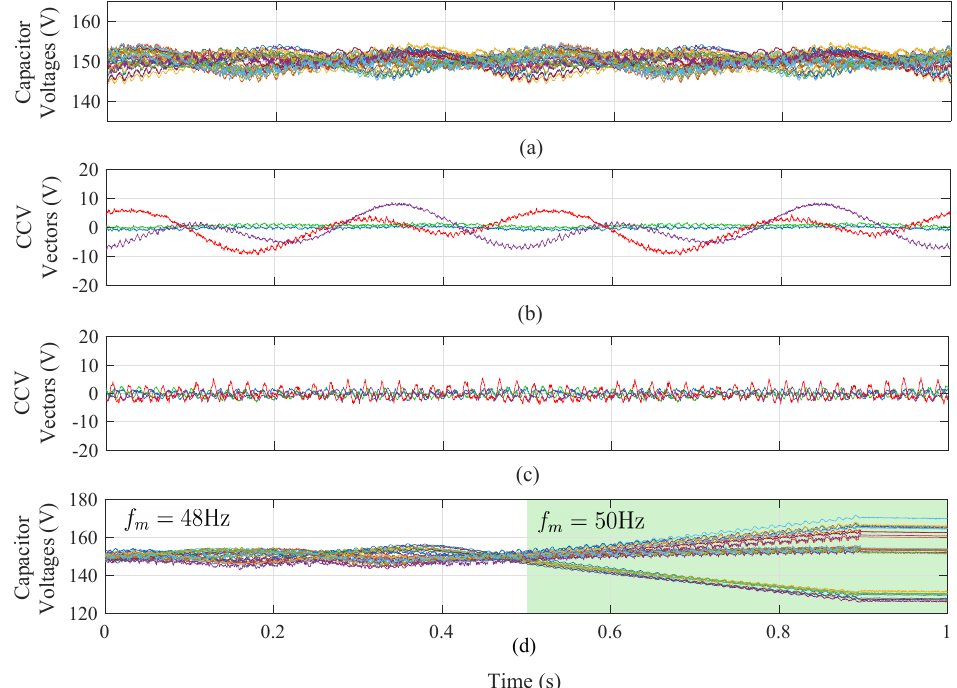
Figure 15. Experimental results considering open loop operation. ( a ) Twenty-seven floating capacitor voltages. ( b ) Four CCV components. ( c ) Four CCV components. ( d ) Twenty-seven Floating Capacitor Voltages. Adapted from